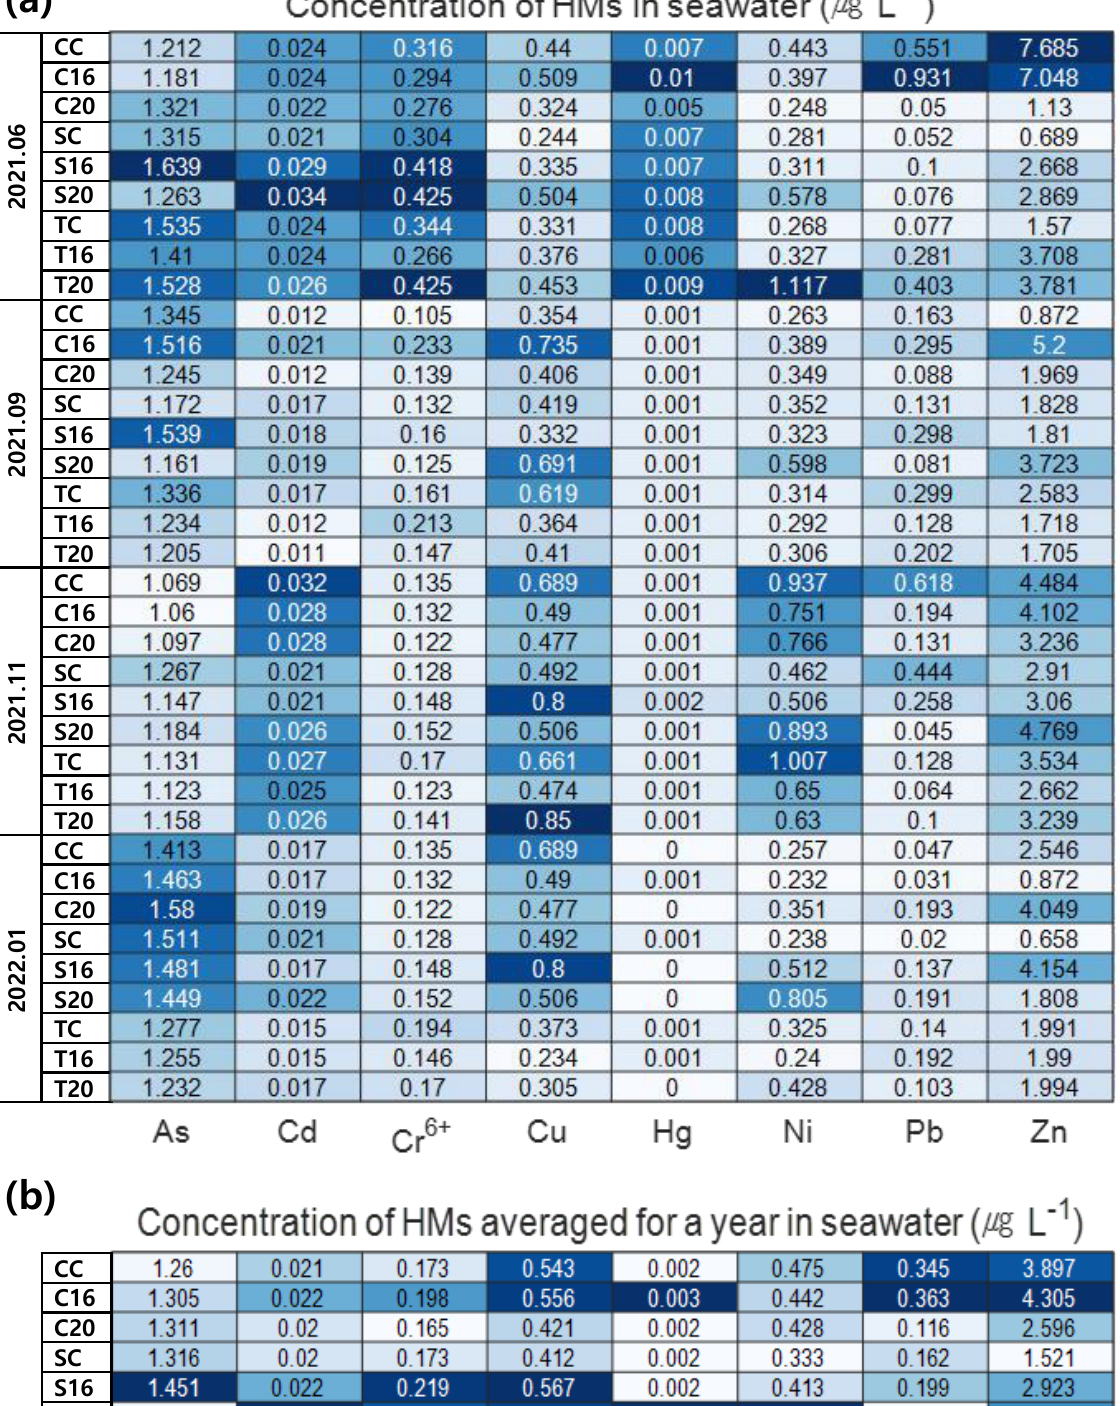
Figure 2. ( a ) Heat map of heavy metal concentrations in seawater collected at control and artificial reef sites in June 2021, September 2021, November 2021, and Janurary 2022 and ( b ) averaged for a year.